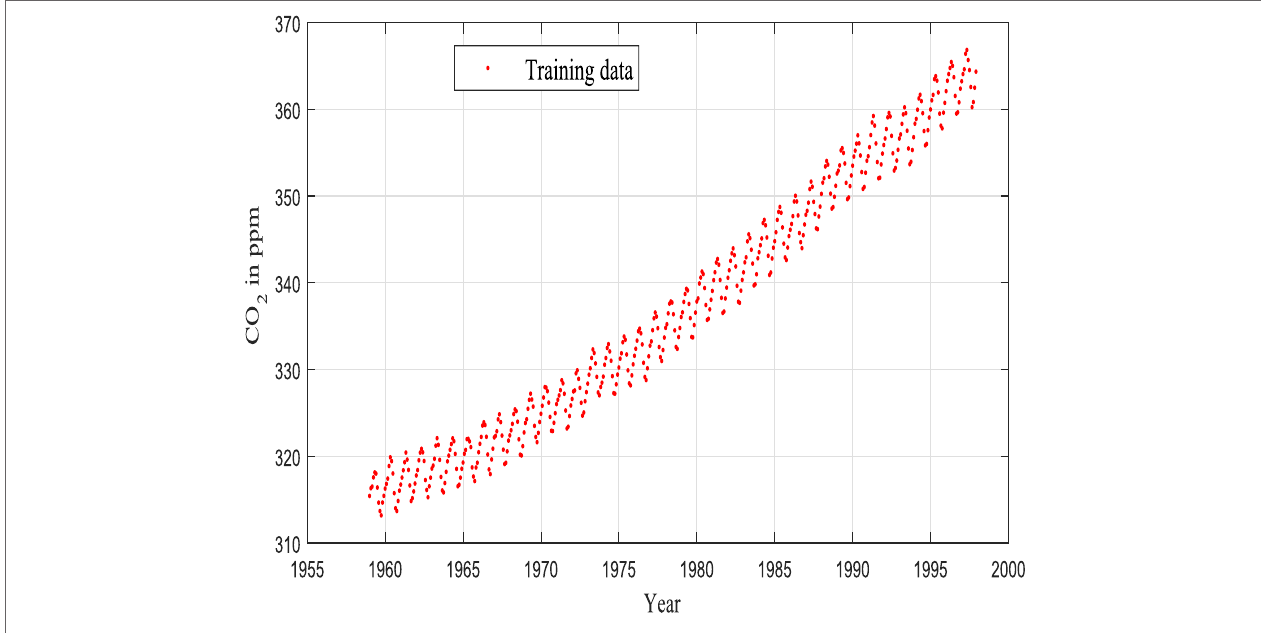
FIGURE 7 | Training data for example